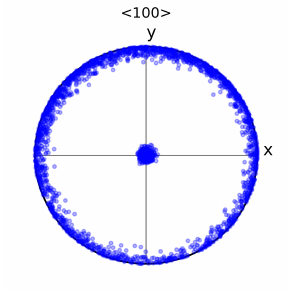
Figure 7. Stereographic projection of the crystallographic orientation of 1000 grains defined by the Euler-angles normal distribution φ 1 = 20 ◦ ± 90 ◦ , Φ = 0 ◦ ± 4 ◦ , φ 2 = 32 ◦ ± 20 ◦